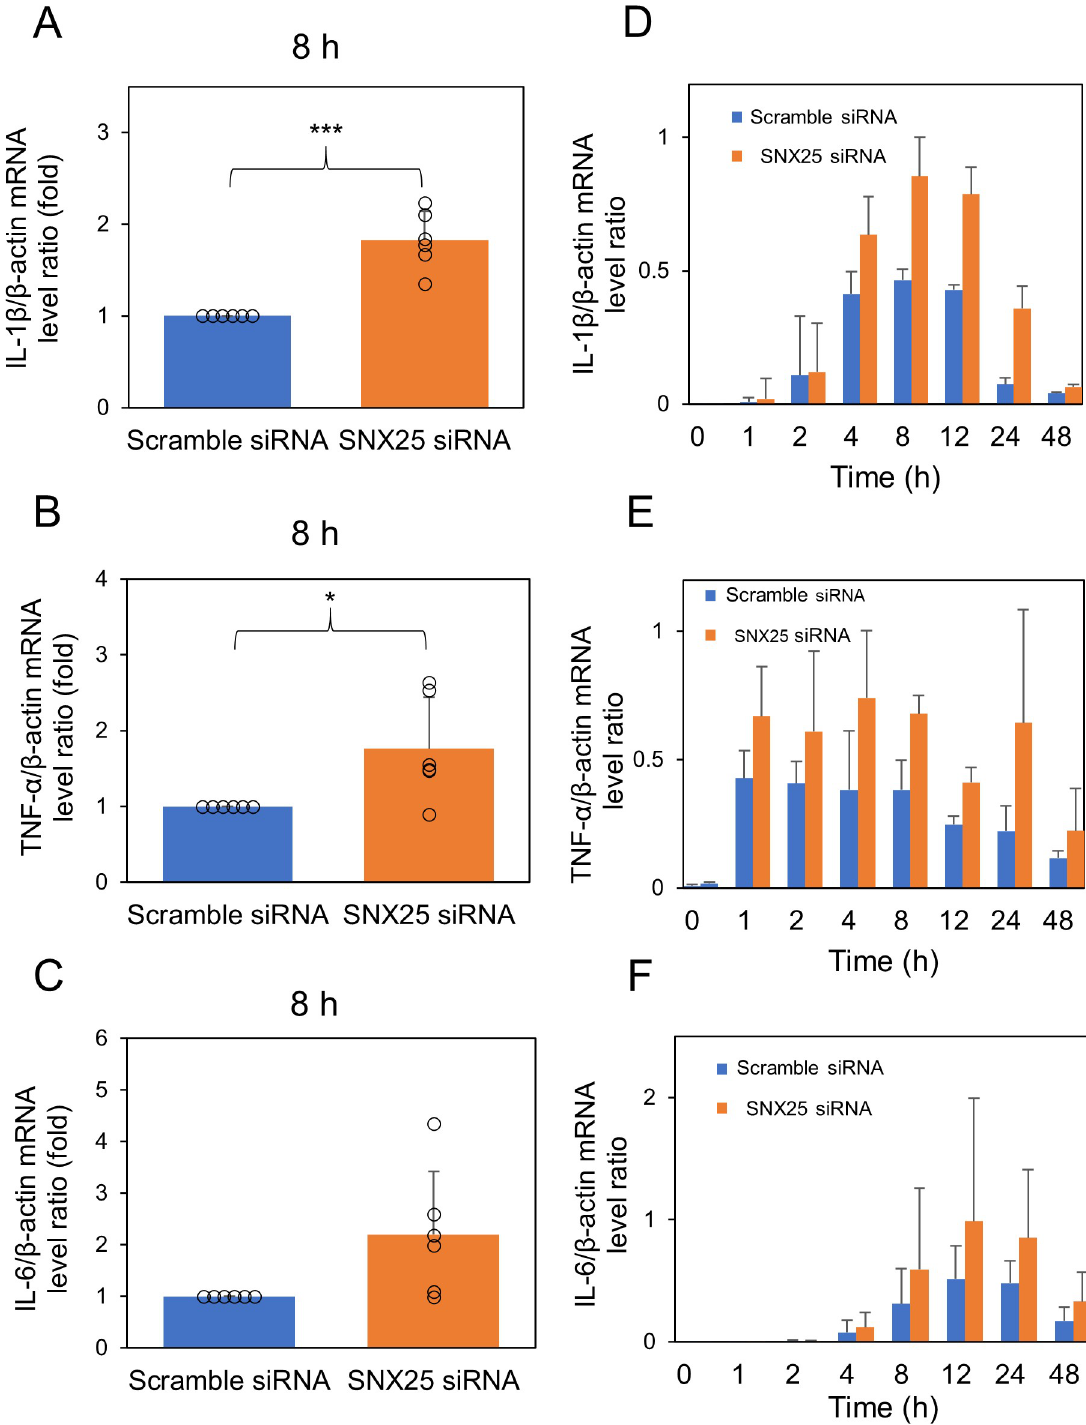
Fig 1. Relative mRNA expression of proinflammatory cytokines in SNX25 knockdown RAW 264.7 cells after LPS stimulation. (A– C) RAW 264.7 cells were stimulated with LPS (1 μ g/ml) for 8 h and mRNA was extracted immediately. RT-qPCR analyzed the relative expression of IL-1 β , TNF- α , and IL-6. β -actin was used as an endogenous control. All data are expressed as means ± SD. Circles indicate the individual experimental values. � P < 0.05 ��� P < 0.001, n = 6, Welch’s t-test. (D–F) RAW 264.7 cells were stimulated with LPS (1 μ g/ ml) for various times and mRNA was extracted immediately. RT-qPCR analyzed the relative expression of IL-1 β , TNF- α , and IL-6. β - actin was used as an endogenous control. All data are expressed as means ± SD. n = 3.